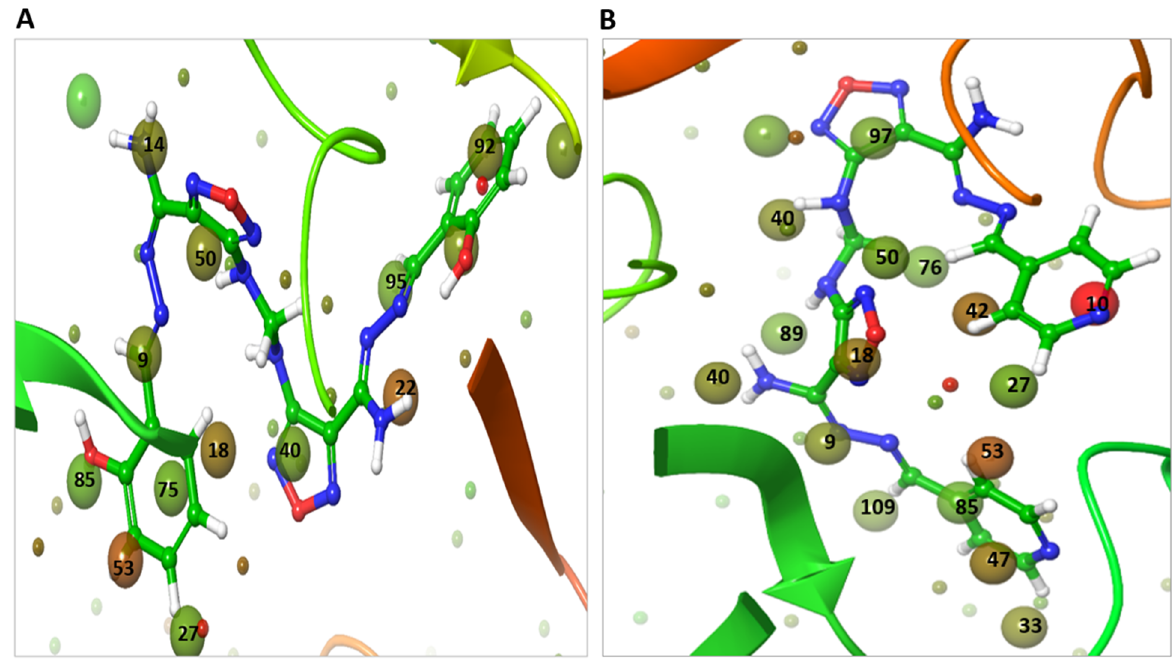
Figure 15. WaterMap analysis of the hydration sites of M pro binding pocket with the docked of pose compounds. ( A ) The overlay and displacement of unstable and replaceable water with Compound 13 . ( B ) The overlay and displacement of unstable and replaceable water with M3. The hydration sites were shown with small spheres. The color spectrum ranged from red (most unfavorable) to green (least unfavorable).